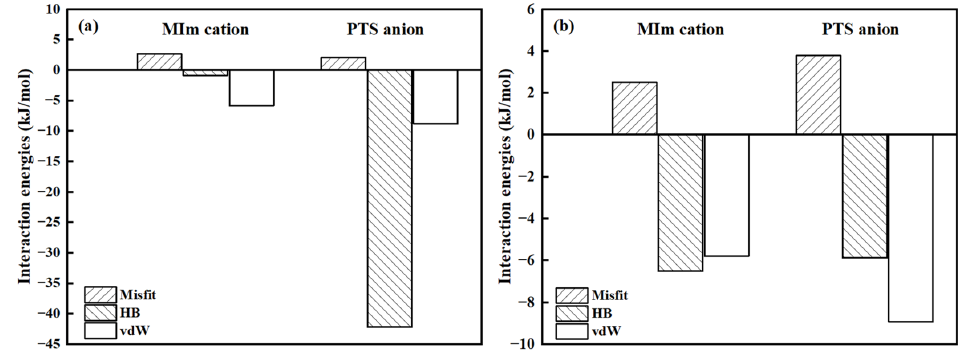
Figure 2. Interaction energies: ( a ) between PTSA and MIm cation or PTS anion; and ( b ) between MIm and MIm cation or PTS anion.